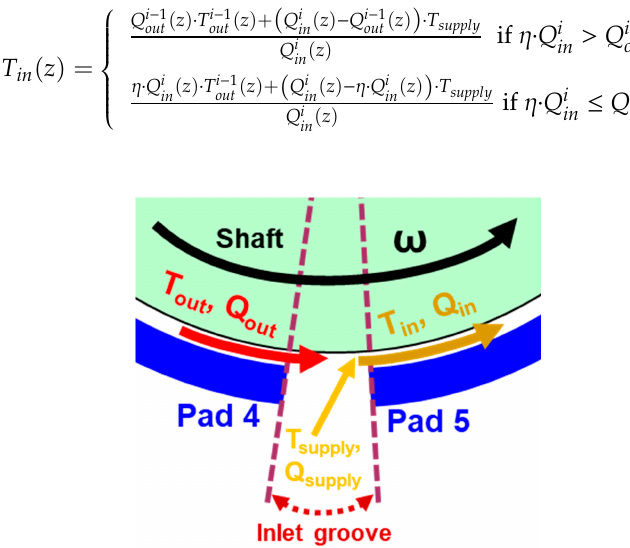
Figure 1. Schematic of oil inlet groove and boundary conditions at pad trailing/leading edges.